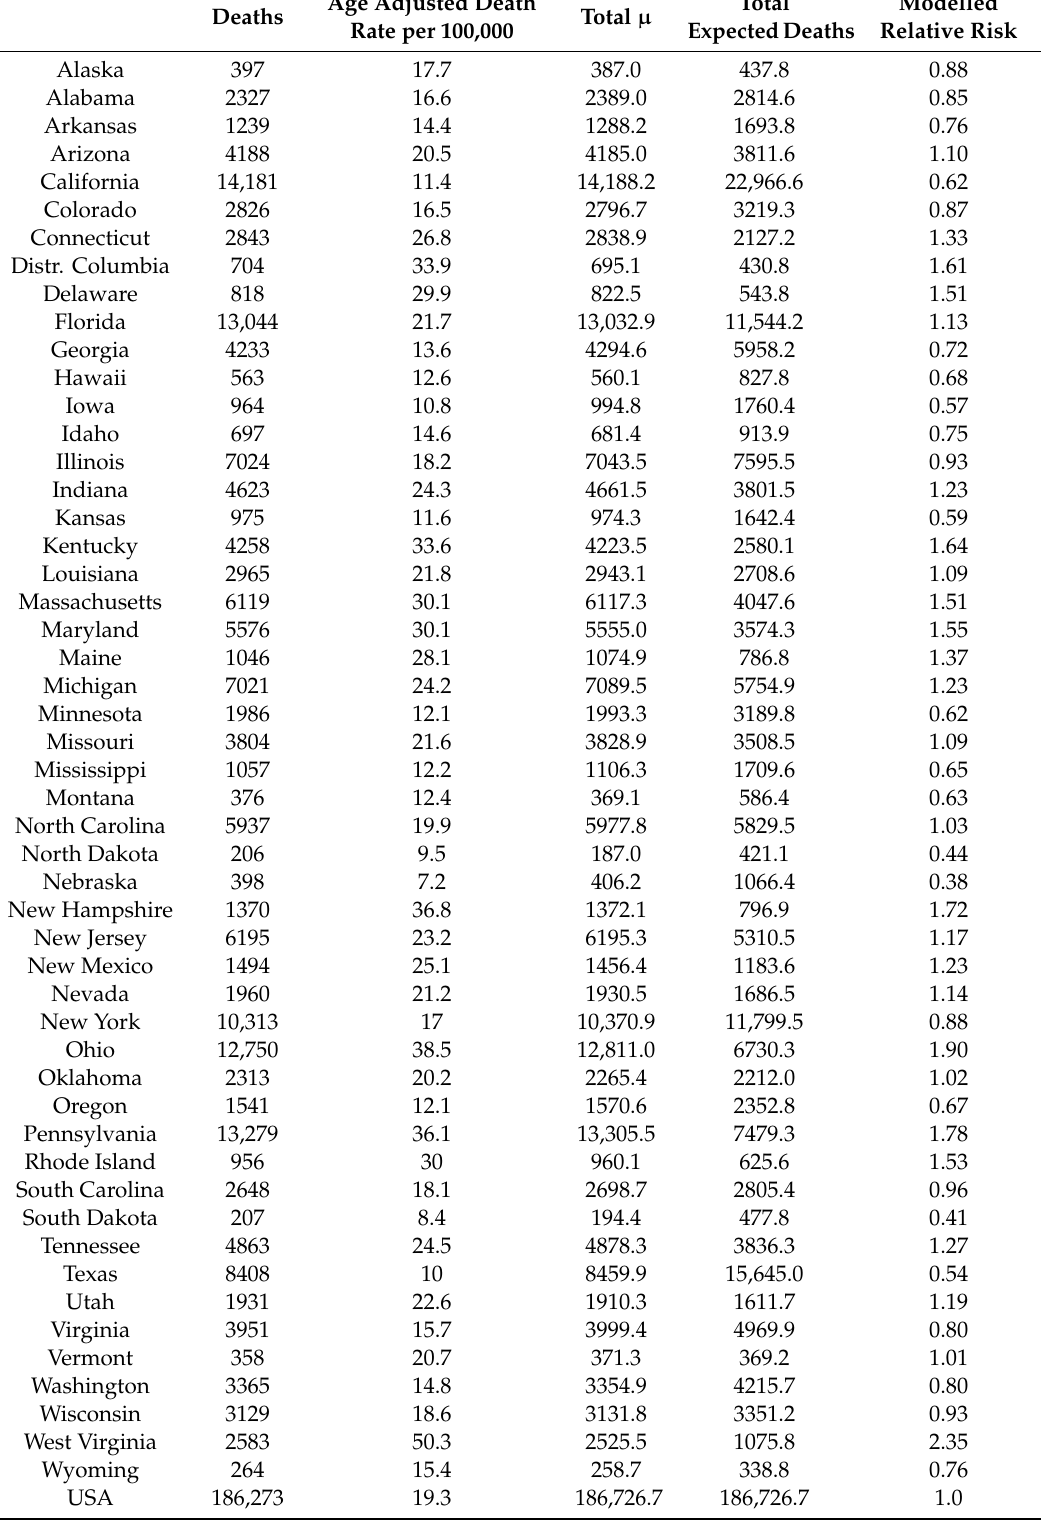
Total Modelled Total µ ExpectedDeaths Relative